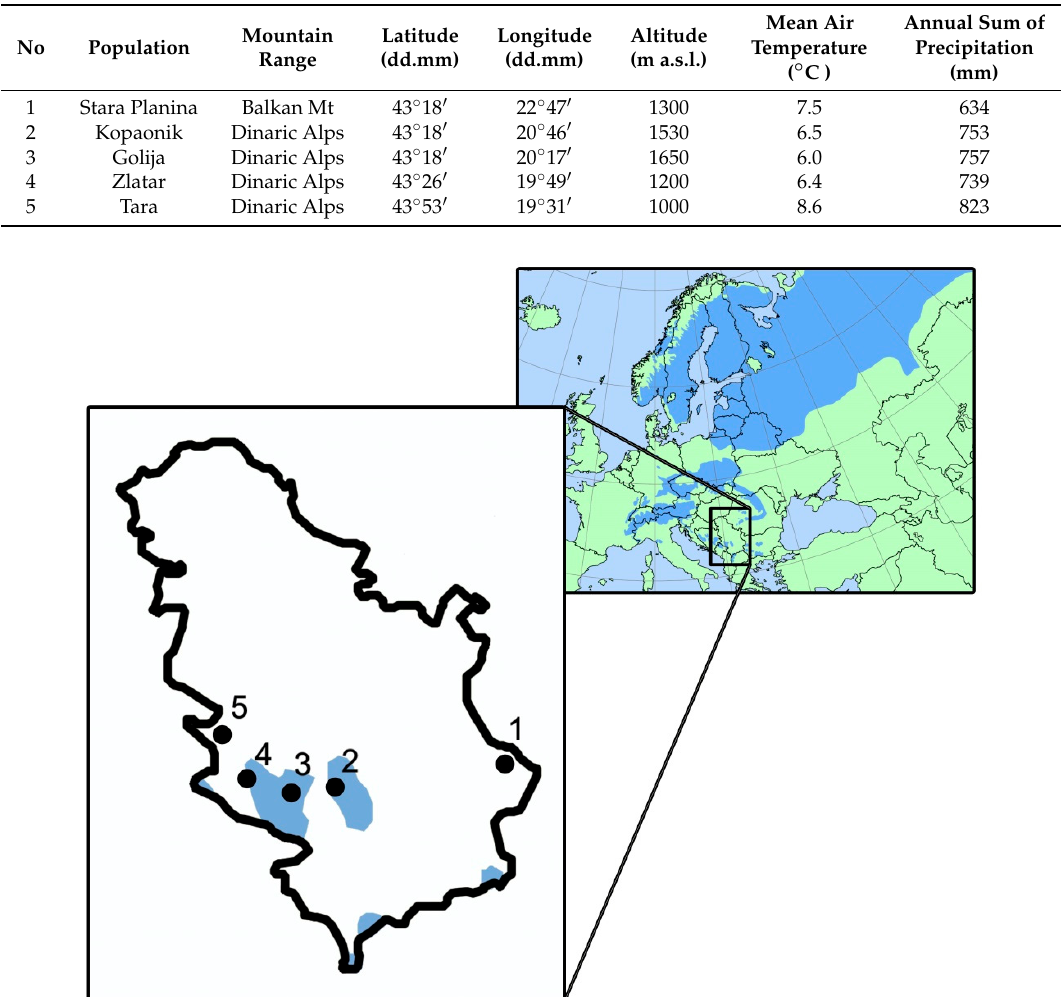
Table 1. Population names, geographic coordinates, altitude, mean air temperature, and annual sum of precipitations.